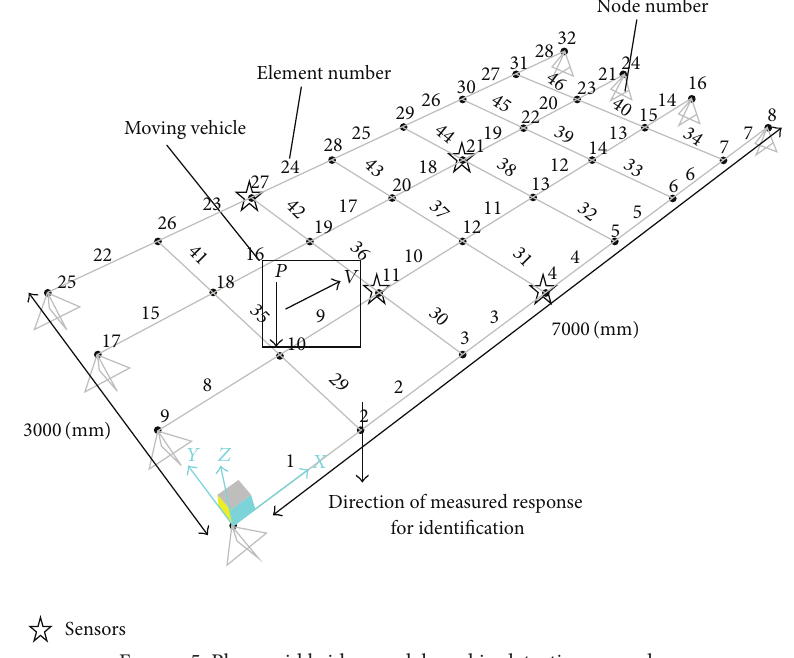
Figure 5: Plane grid bridge model used in detection procedure. Table 7: Damage scenarios for multispan